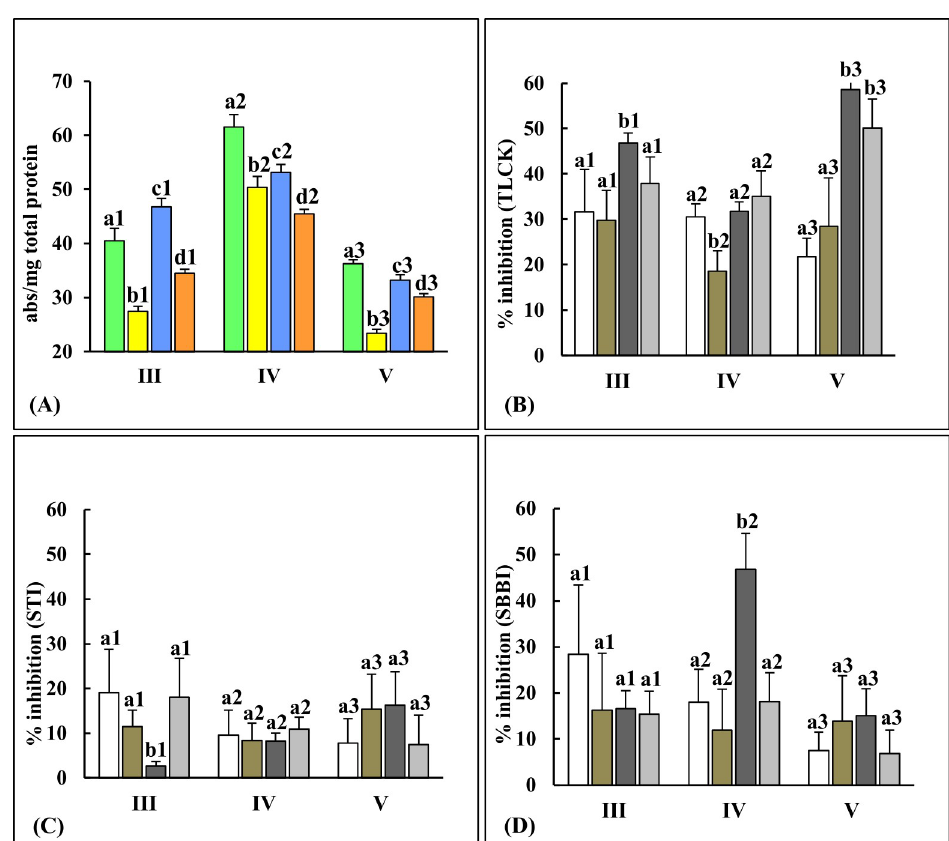
Fig 2. P . brassicae gut protease activities measured using casein as substrate reveals rapid changes in enzyme levels upon switching to a new diet type. Panel A: Total gut caseinolytic activities detected in III, IV and V instars (n = 36) fed on CF-CF (green), CF-GN (yellow), GN-CF (blue), and GN-GN (orange) diets, in no-choice, fixed time experiments. Inhibition of total protease activity by 3 protease inhibitors (panel B: 10mM TLCK, panel C: 0.05mM STI and panel D: 0.125mM SBBI) is shown. The % inhibition is relative to the protease activity detected in each corresponding gut sample. Bars depict mean ± SE. Significant differences (at p � 0.05, Tukey’s HSD test) are depicted by different